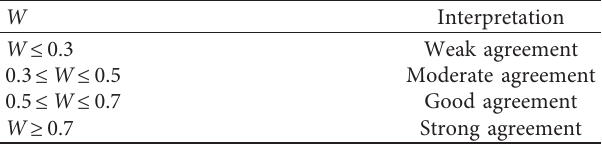
Table 2: Interpretation of Kendall’s W